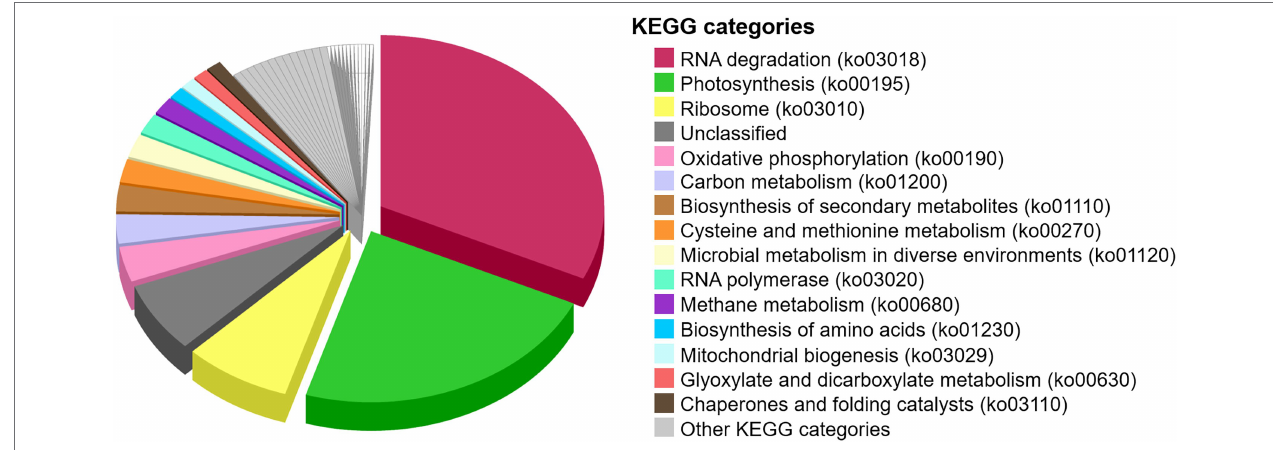
FIGURE 8 | Proportion of metabolic pathways in the desiccated microbial mat based on the functional assignment of the metaproteome to KEGG pathway maps. The relative abundance of KEGG categories was calculated based on the sum of SAFs of the proteins that are annotated in each KEGG category. “Unclassified” are proteins unable to cross-reference with the KEGG database. “Other KEGG categories” are shown in Supplementary Figure 6